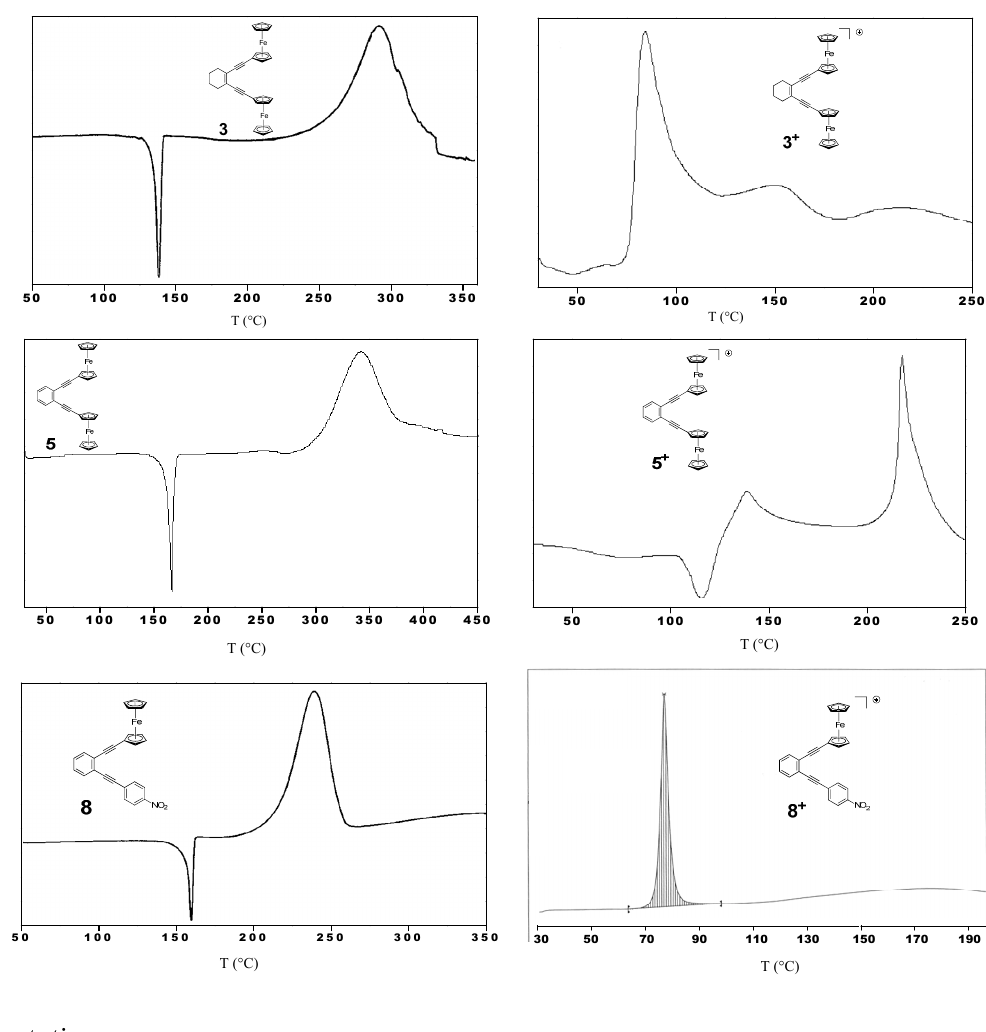
Figure 4. DSC graphs of 3 , 5 and 8 and their monocations 3 + , 5 + and 8 + (heating rate: 10 °C·min − 1